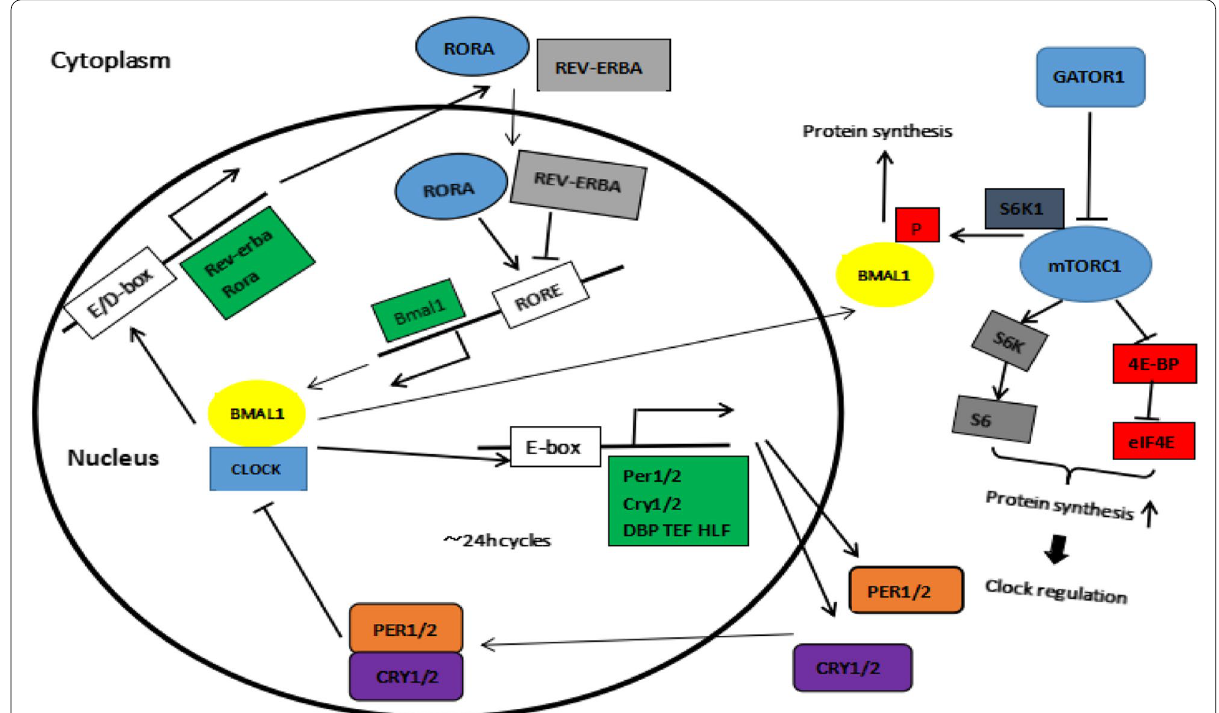
Fig. 1 A general overview ofmolecular mechanisms. There are two vital genes for the generation of thecircadian clock in the SCN cells, Clock gene and Bmal1 gene. The protein products of thesegenes form a heterodimeric CLOCK/BMAL1 complex in the cytoplasm. The CLOCK/BMAL1 complex translocates to the nucleuswhere it binds to specific E-box motifs and then drives the transcription of target genesincluding Cry1-2, Per1-3 , and other downstream genes (PAR bZIPtranscription factor genes TEF, DBP, HLE ). The mRNAs of Pers and Crys are transcribed and thentranslated into PERs and CRYs in the cytoplasm. The increased PERs and CRYs dimerize and translocate into the nucleus where they reduce the transcriptional activityof the CLOCK/BMAL1 complex, resulting in restraint of their own transcription. Additional feedbackloops begin when the transcription of two retinoic acid-related organ receptor response elements REV-ERBA and RORA is activated by the CLOCK/BMAL1 complex. The protein products of REV-ERBA(repressor of Baml1 transcription) and RORA (activator of Baml1 transcription)enter the nucleus where they competitively bind to the promoter of Baml1 geneto stimulate the expression of Baml1. The GATOR1 complex can suppress theactivity of the mTOR pathway. The S6K1 kinase of the mTOR pathway can activate Baml1 via phosphorylationto regulate the function of BMAL1 and control circadian protein synthesis.mTORC1 regulates the phosphorylation-dependent S6K and eukaryotic translation initiationfactor 4E-BPs. The activated S6K stimulates S6 phosphorylation while 4E-BP1 phosphorylation causes its dissociation from eIF4E, which increasesprotein synthesis and then leads to a rapid clock system regulation. Clock circadian locomotor output cycles, Bmal1 brain and muscle ARNT-like 1, Cry Cryptochrome, Per1 Period, TEF translation elongation = = = = = factor, DBP D-box bindingprotein, RORA RAR-related orphan receptor α, REV-ERBA reverseerythroblastosis virus α, mTOR mammalian = = = = target of rapamycin, GATOR1 GAPactivity toward Rags 1, S6K1 ribosomal S6 protein kinase 1, 4E-BP 4E-binding protein, eIF4E eukaryotic = = = = translation initiationfactor